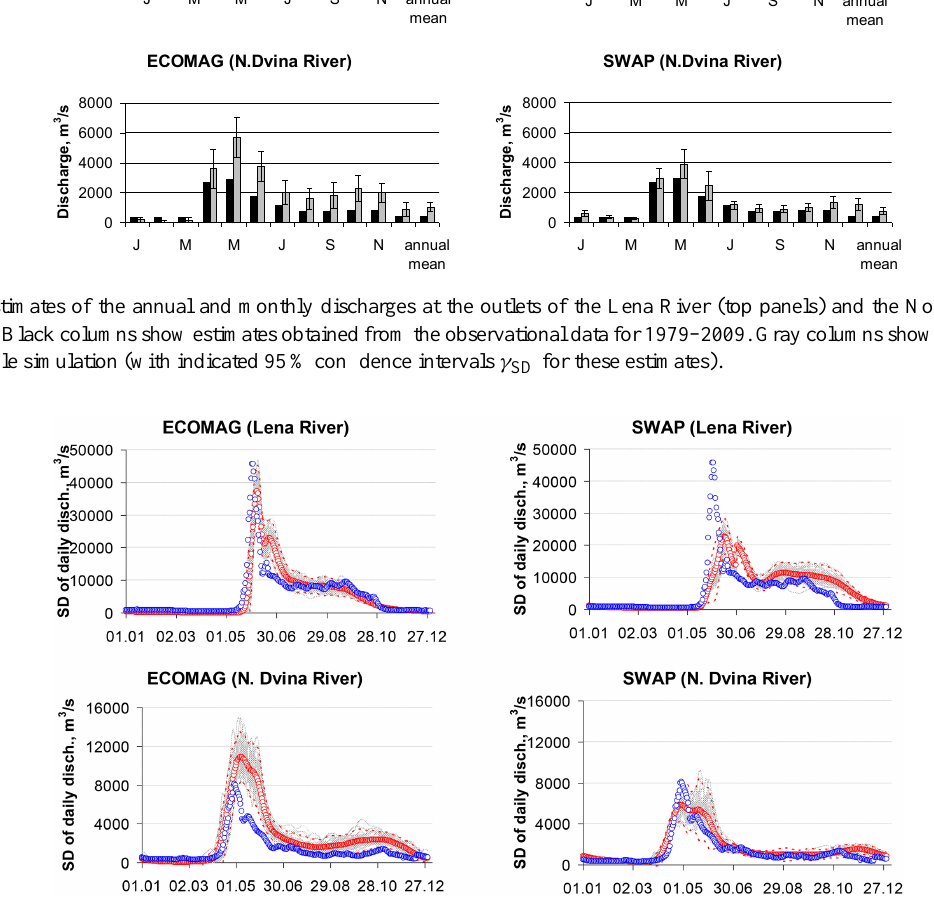
Figure 10. SD estimates of the daily discharges at the outlets of the Lena River (top panels) and the Northern Dvina River (bottom pan- els). Blue points show estimates based on observational data for the period of 1979–2012. Red points show estimates based on ensemble simulations (gray thin lines). Red dotted line shows the boundaries of the 95% confidence interval of mean daily